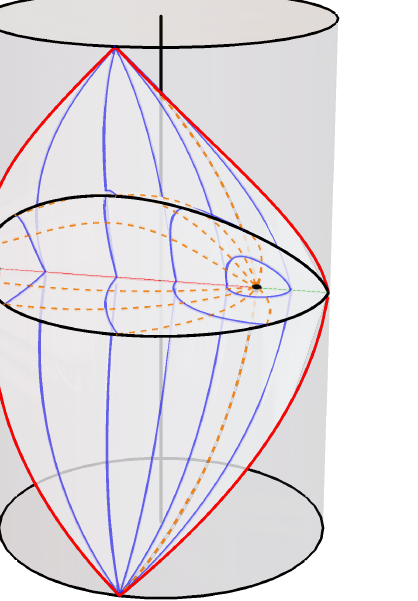
JHEP05(2022)063